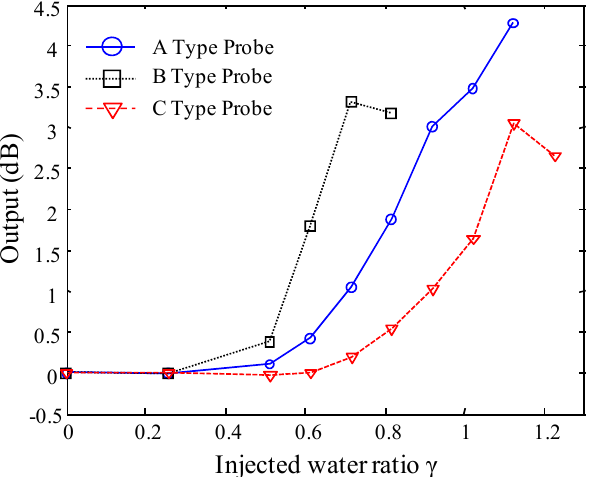
Figure 11. Sensor outputs according to injected water ratio of three types of